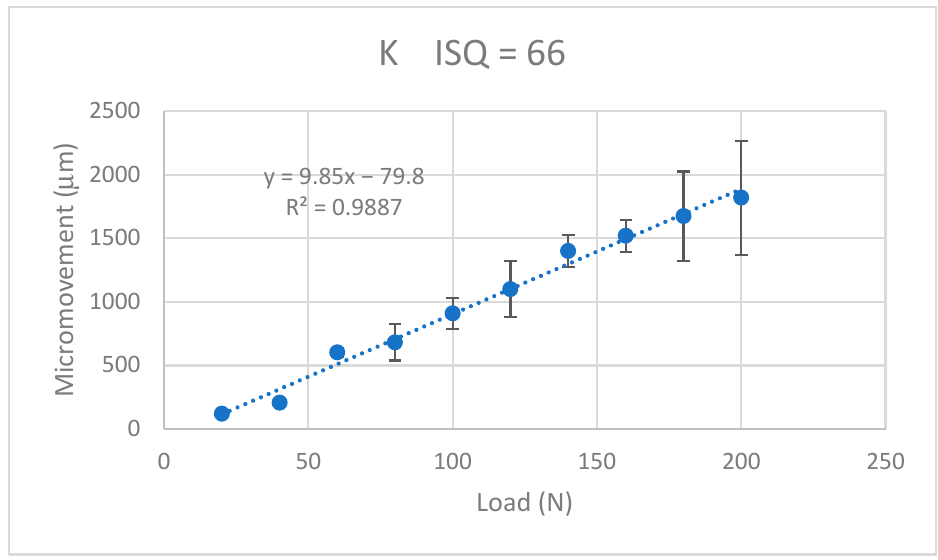
Figure 9. Micromovements in micrometers associated with the load in N for the K implants. The equations that related the micromotions to the applied force fitted the lines with correlation coefficients greater than 0.9 for each type of dental implant, as can be seen in Table